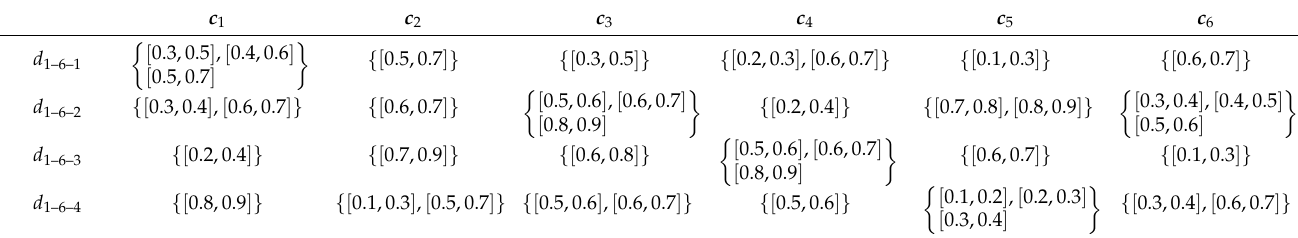
Table A6. Scoring matrix of cost d 1–6 .